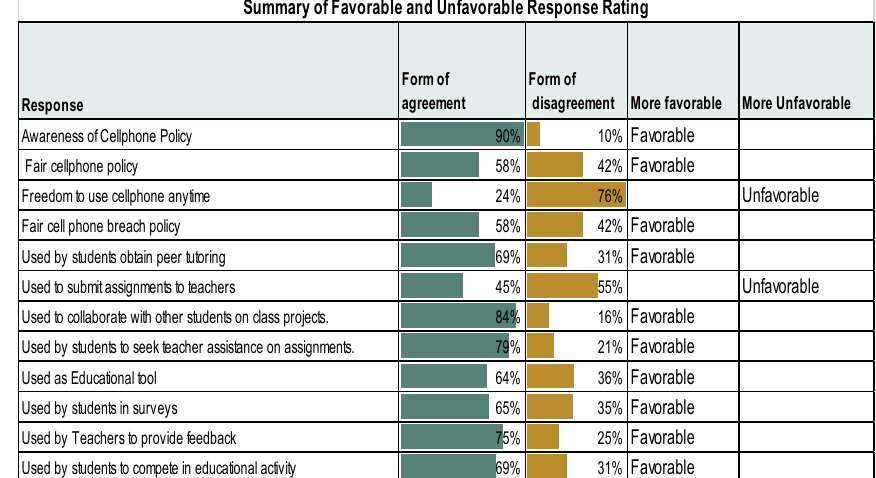
Figure 12. Summary of favorable and unfavorable